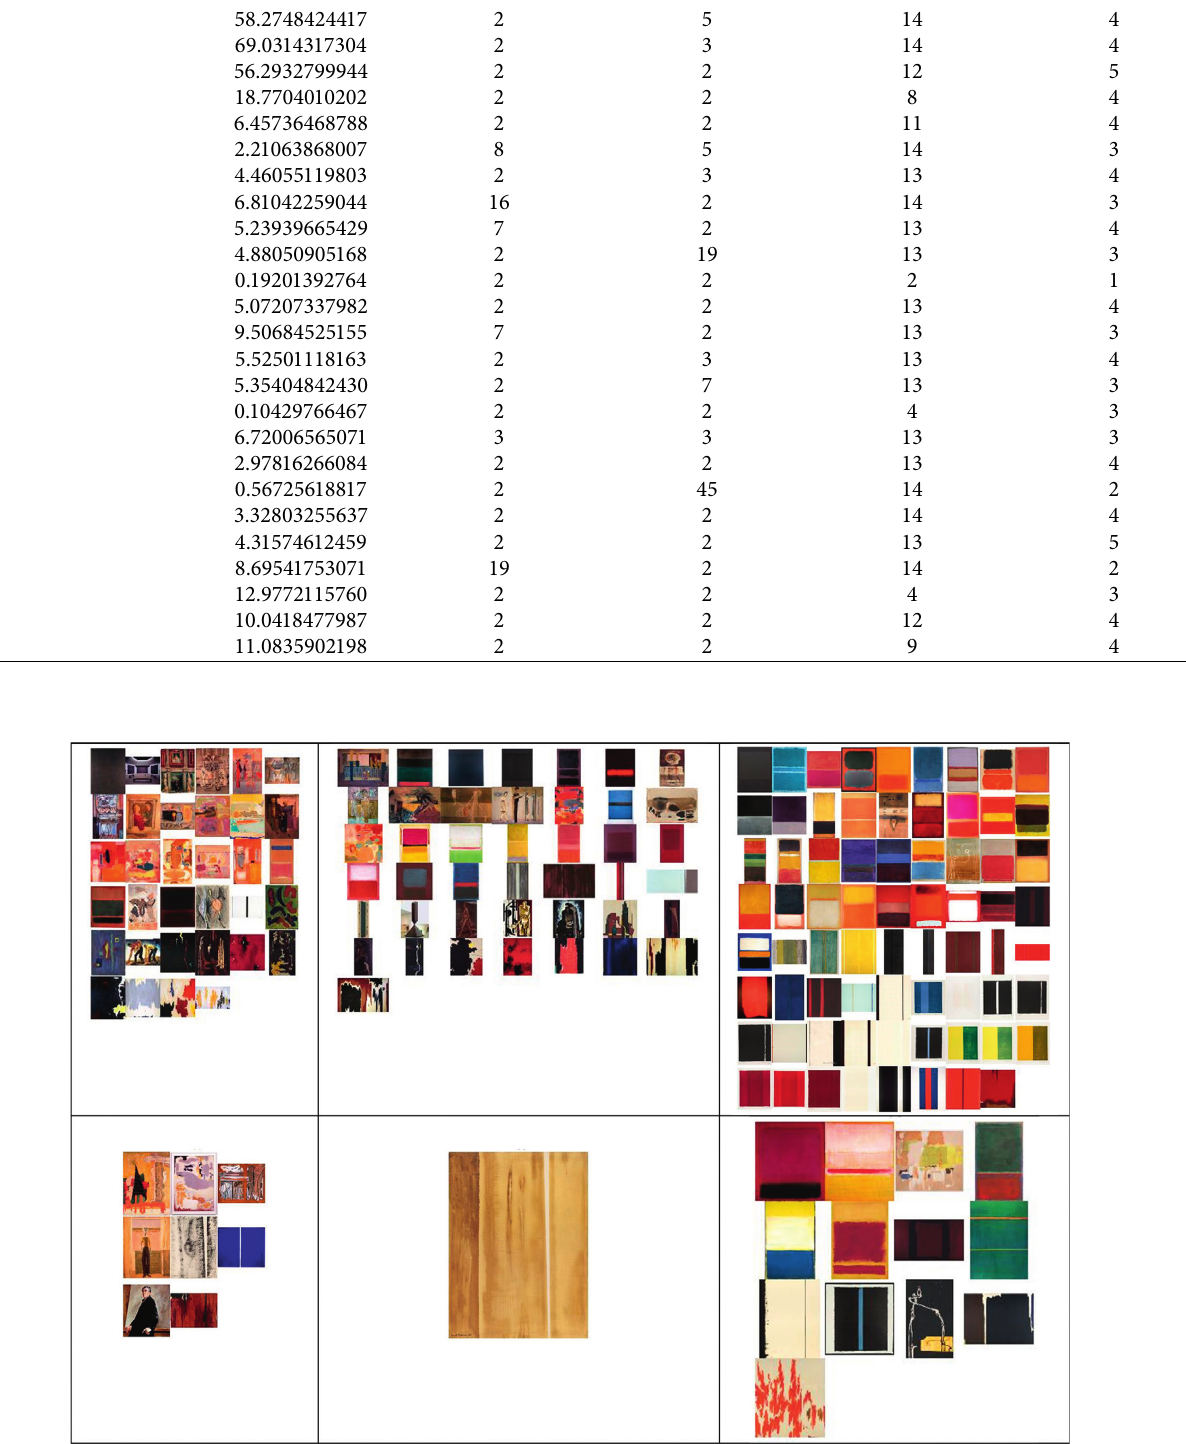
Figure 11: Level 1 SOM of IR with 2 rows and 3 columns. The neurons have the following number of elements respectively: 34, 43, 71, 8, 1, 5 and